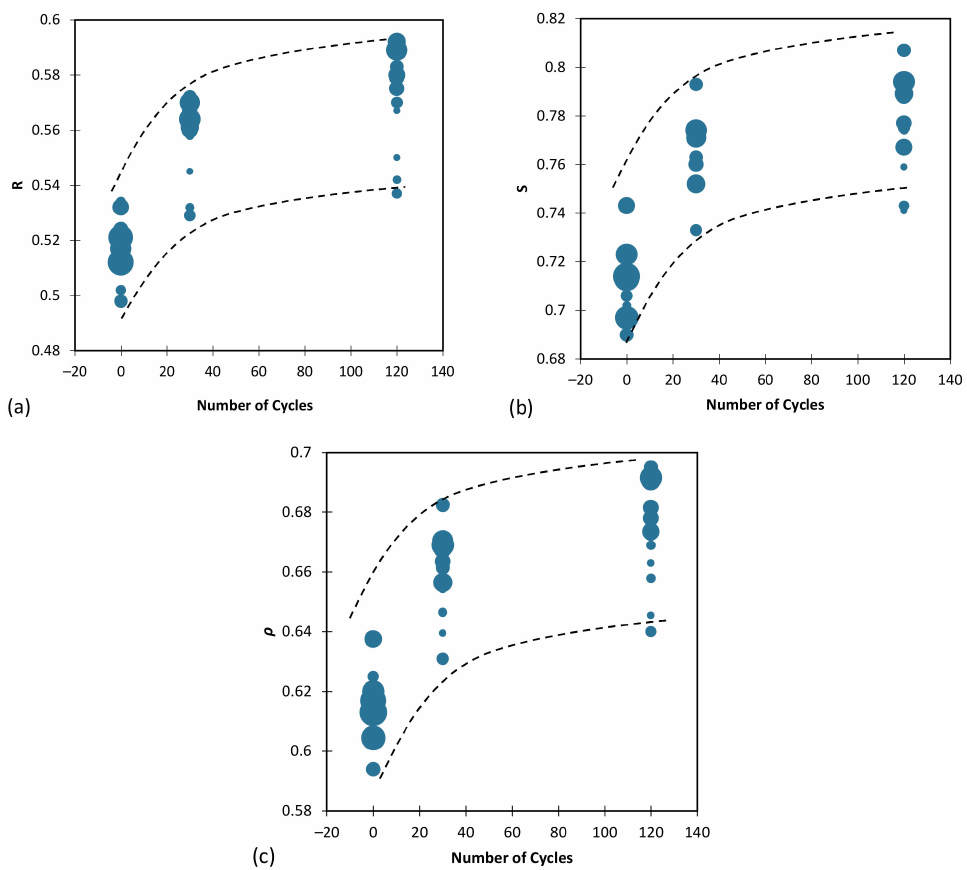
Figure 14. Effects of number of loading cycles, along with ( a ) R , ( b ) S and ( c ) ρ , on the damping